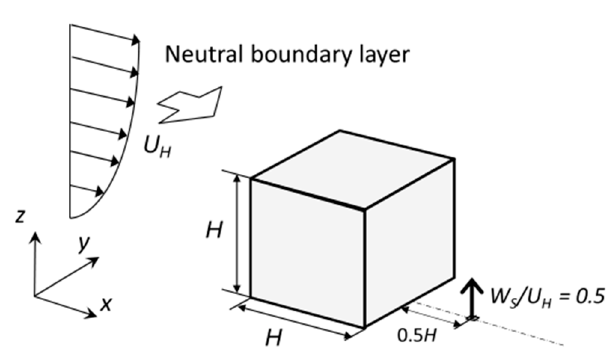
Figure 1. Single building model (Tominaga et al. [21]). Numerical